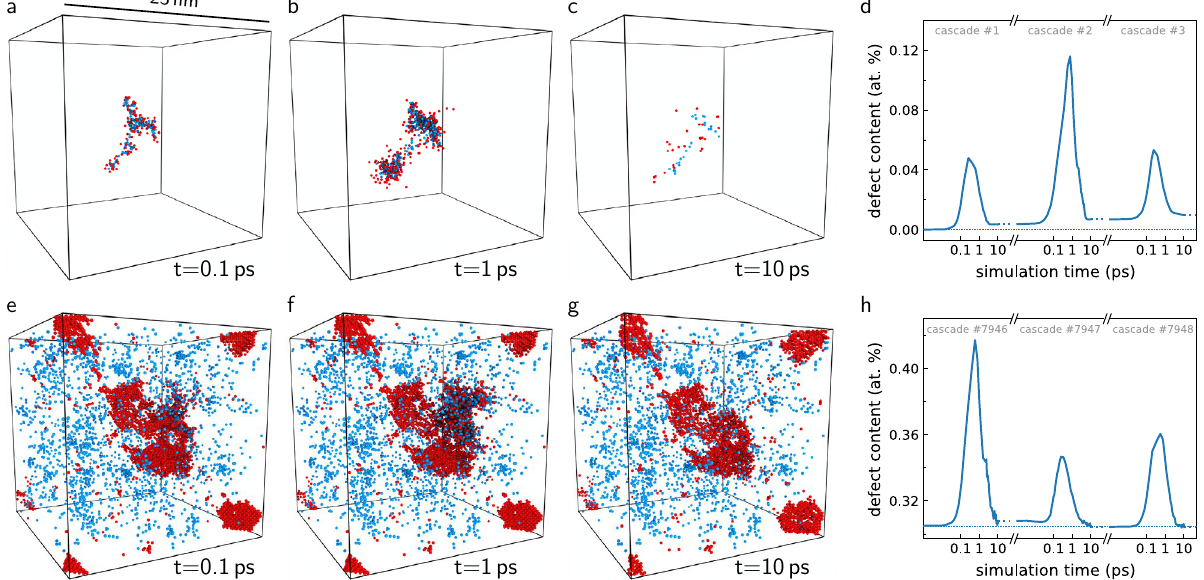
Figure 1. Displacement damage in the driven dynamic steady state of a material exposed to radiation. Damage evolution after initialisation of a cascade with 30 keV recoil energy in ( a – c ) pristine tungsten and ( e – g ) tungsten previously irradiated to 1 dpa. Shown are only the crystal defects identified using the Wigner–Seitz defect analysis as interstitials (red) and vacancies (blue). ( d , h ) Evolution of the defect content produced by cascade initiation. In pristine crystalline tungsten, the defect content increases linearly with each cascade event, while in the already irradiated tungsten, the defect content fluctuates around a mean value; no new defects are generated as the microstructure is in a steady-state with respect to